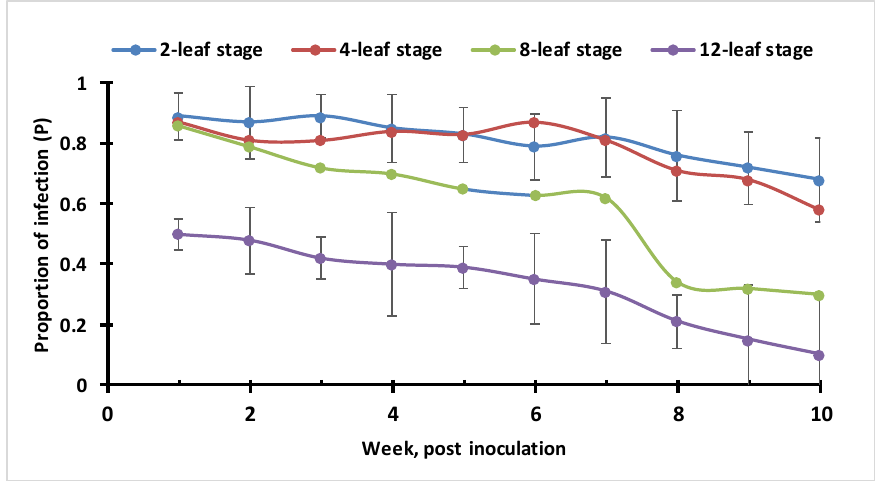
Figure 11. Plant age and ChiLCV transmission potential in susceptible chilli genotype (cv HPH-1041) estimated under semi-controlled conditions.